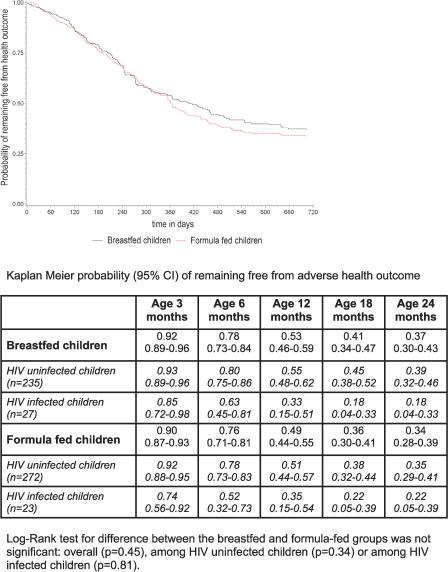
Two-Year Probability of Remaining Free from Adverse Health Outcome (Hospitalization or Death or Validated Morbidity) According to the Feeding Group and Pediatric HIV StatusANRS 1201/1202 Ditrame Plus study, Abidjan, Côte d'Ivoire, 2001–2005 (n = 557).